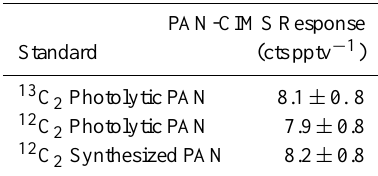
Table 1. Comparison of TD-CIMS sensitivity to 12 C 2 - and 13 C 2 -